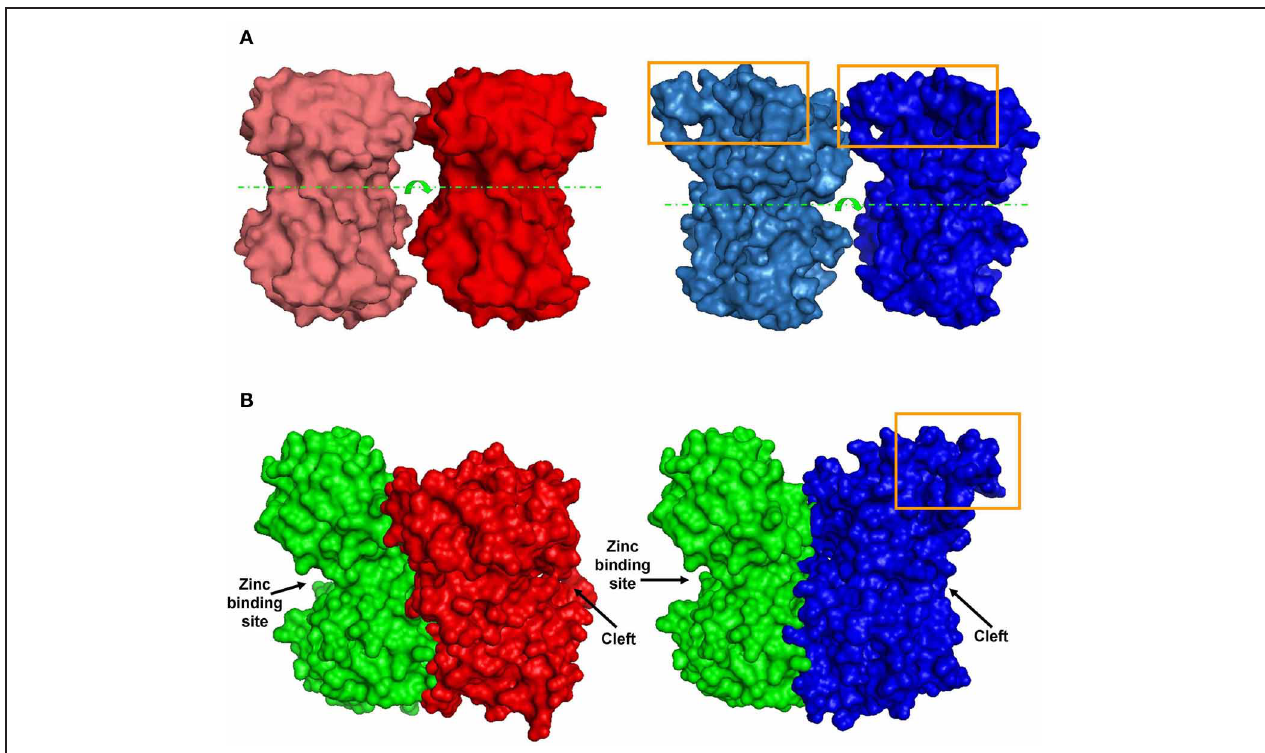
cleft. Arrows represent the cleft’s direction. (B) GluN1-GluN2 heterodimer 3D structures. Left—docking of GluN1-1a NTD (red) to GluN2A NTD (green). Right—docking of GluN1-1b NTD (blue) to GluN2A NTD (green). Note that the loop of 21 extra amino acids in GluN1-1b (orange box) faces out and does not interfere with sub-domain interaction. The figure was created using